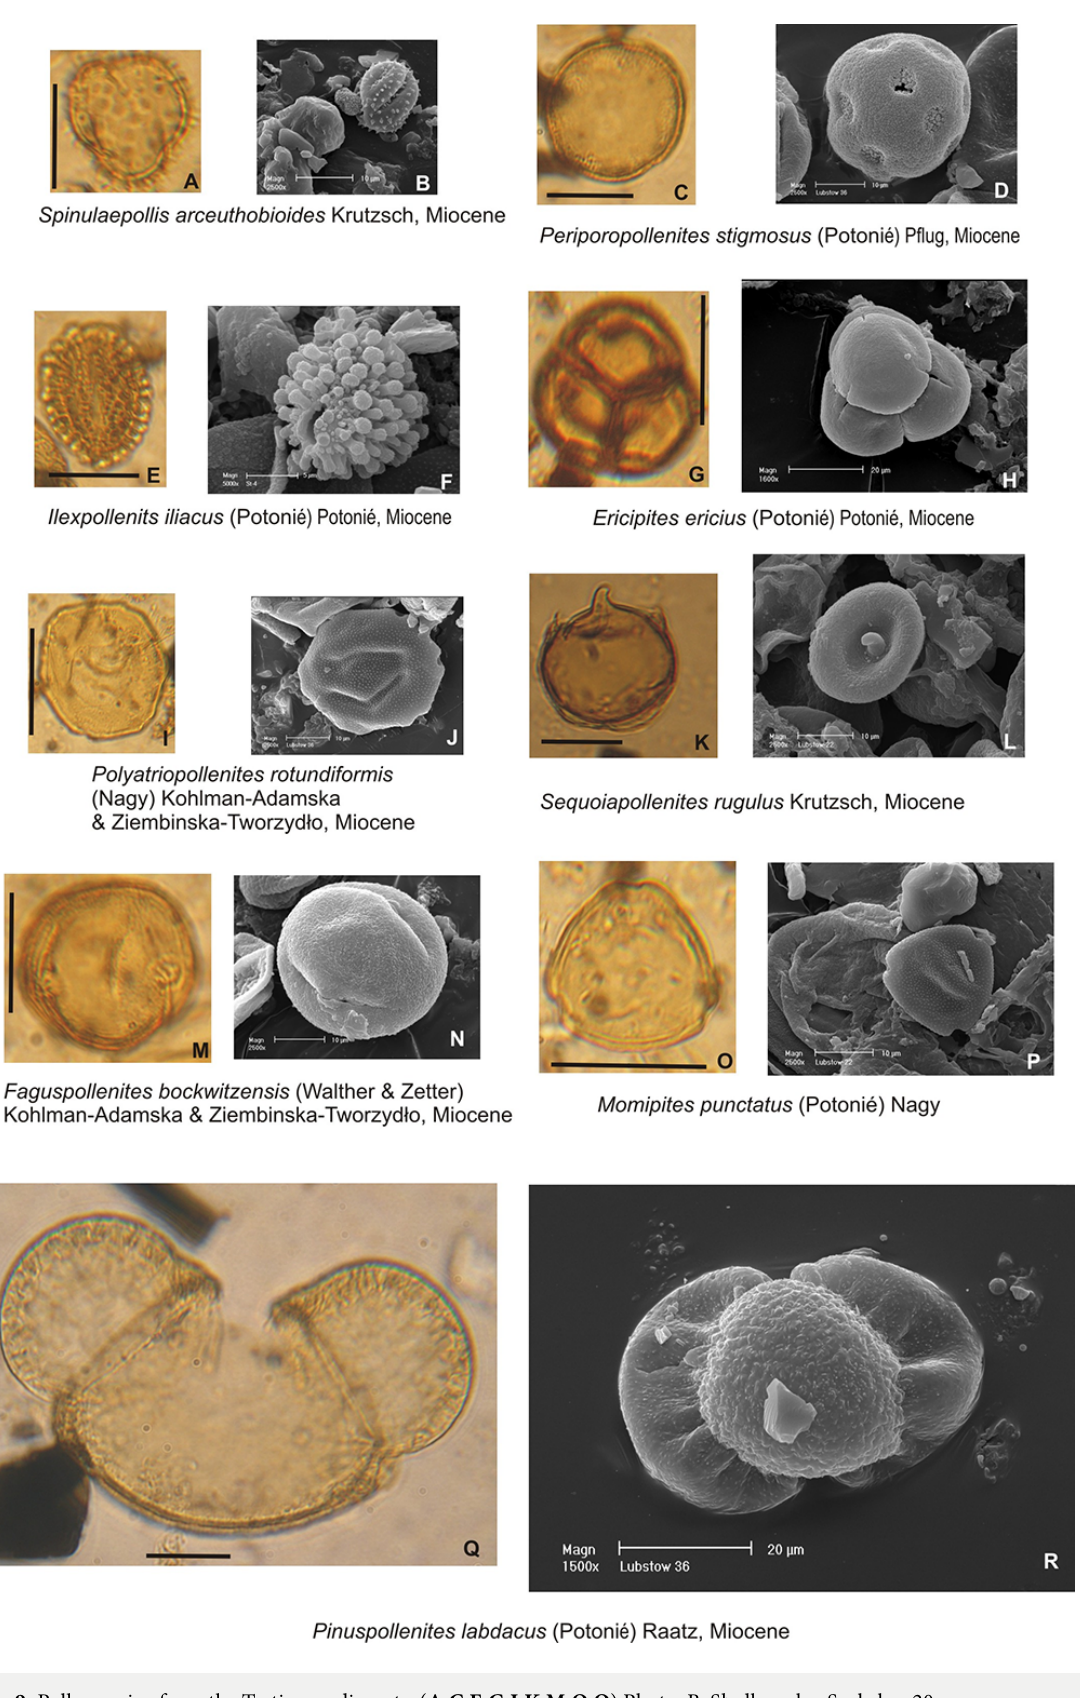
ActaSocietatisBotanicorumPoloniae / 2022 / Volume 91 / Article 9122 Publisher: Polish Botanical